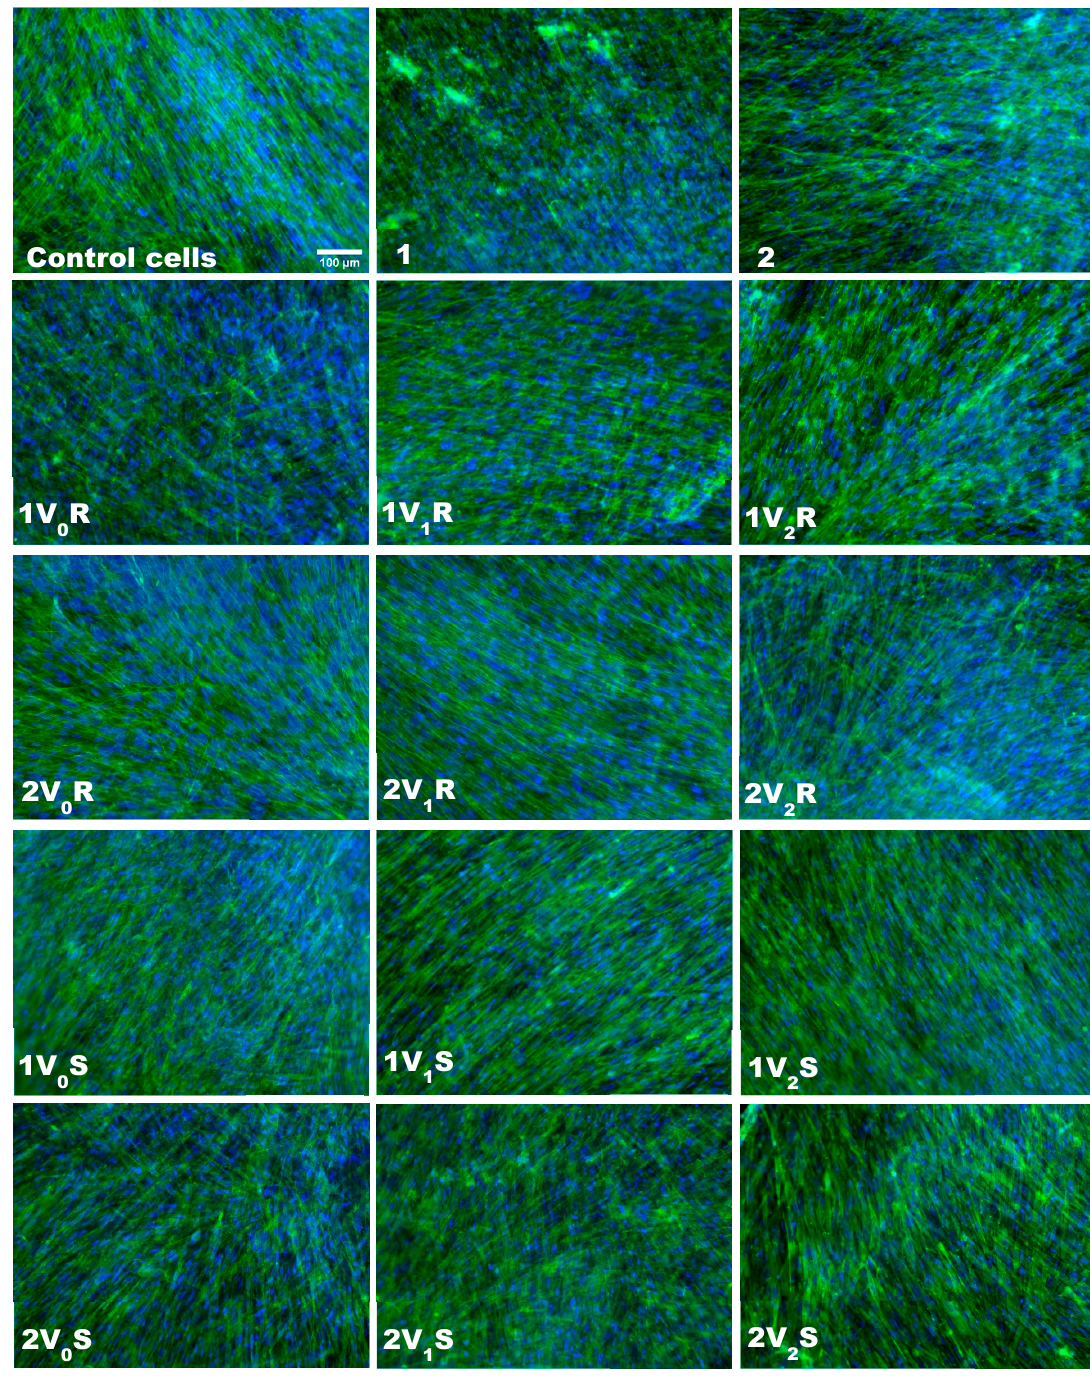
Figure 3. Fluorescence images of actin filaments (green) and nuclei (blue) staining in human dermal fibroblasts cultured on inserts in the presence of fabrics treated in different experimental variants with sage (S) and rose (R) microcapsules for 12 h. Scale bar of 100 µm shown on first micrography is the same for all images.